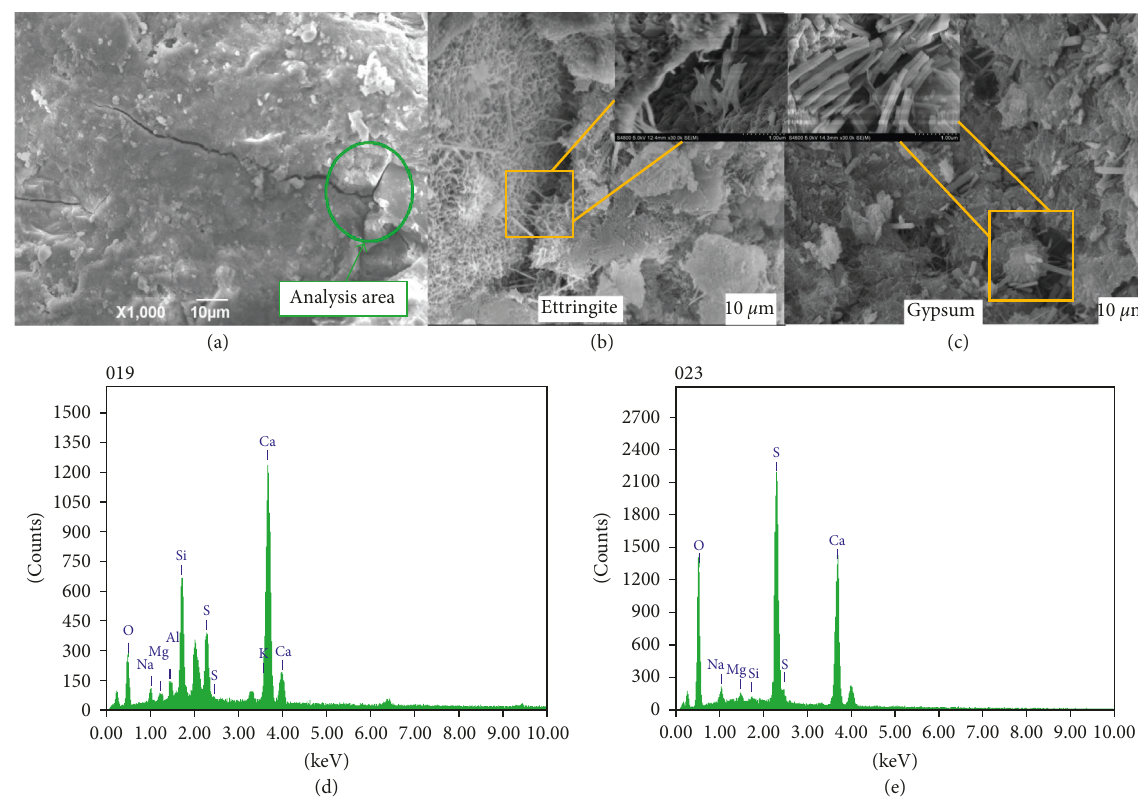
Figure 12: (a) SEM of thin sections from DW-1 specimen before chemical exposure, (b) SEM image from DW-1 specimen with ettringite, (c) SEM image from DW-1 specimen with gypsum in cracks and pores, (d) EDX analysis of squared area in (b) showing ettringite components, and (e) EDX analysis of squared area in (c) showing gypsum